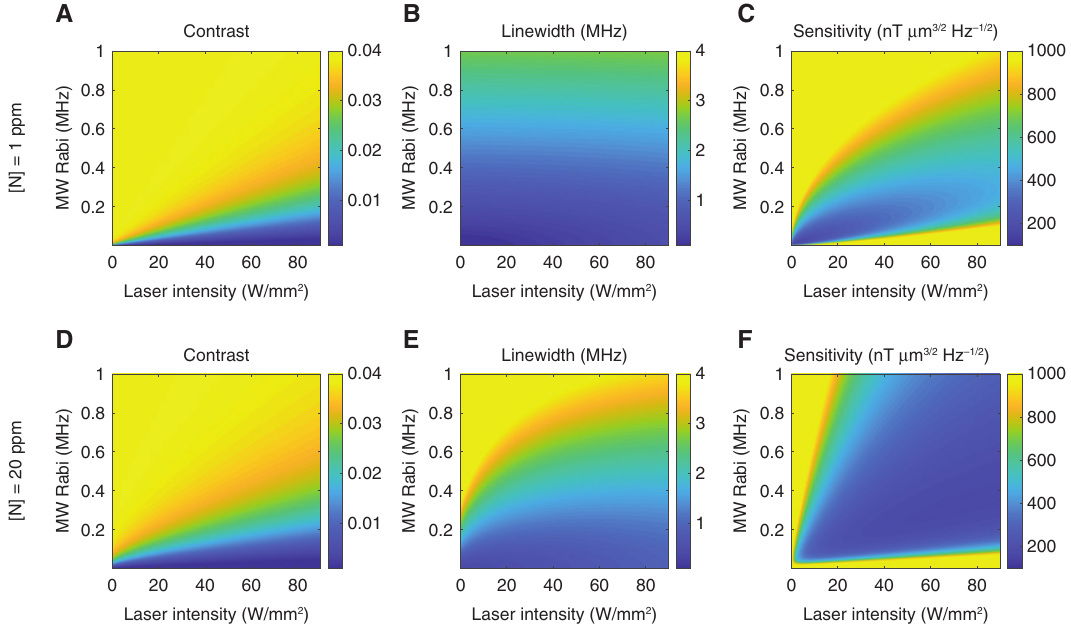
Figure 10: Ensemble CW ODMR sensitivity analysis. Simulations of (A, D) CW ODMR contrast, (B, E) linewidth, and (C, F) volume-normalized magnetic field sensitivity ( η intensity and MW Rabi (which scales as the square root of the input MW power) with parameters from Table 1 for a diamond with 1 ppm of nitrogen (top row), and a diamond with 20 ppm nitrogen (bottom row). Laser intensity scale assumes saturation intensity of 0.9 MW/cm 2